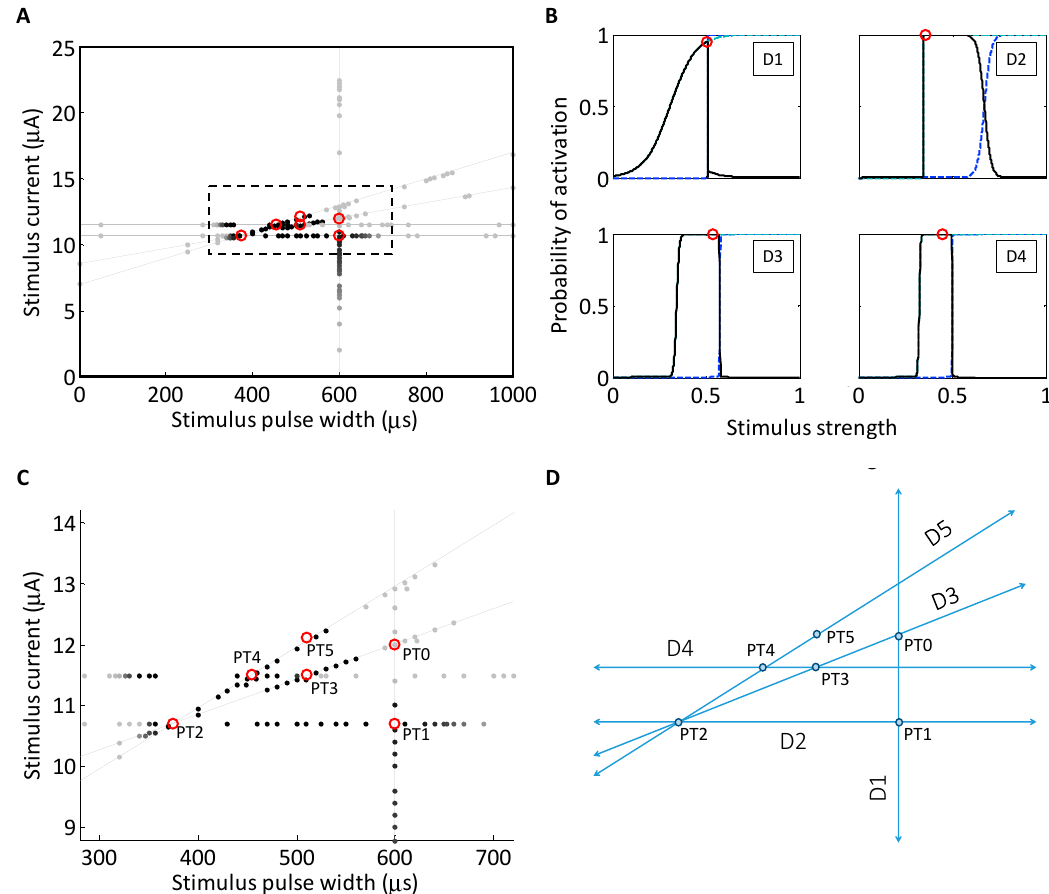
Figure 6. ( A ) Implementation of Powell’s method to search the strength–duration waveform space. The thin lines denote the five search segments. The stimuli applied along each stimulus path is color coded such that the darker the point, the greater the selectivity between the two neurons. The maxima found along the search lines are highlighted with open circles; ( B ) the objective function (solid line) was evaluated along each line search in the search routine of ( A ) according to Equation (3). The objective function for each of the first four searches is plotted in each panel, and the maximum of the objective function is denoted with an open circle, similarly to ( A ). The sigmoidal activation functions for each of the two neurons, N1 and N2, are plotted with dotted lines. The outputs from the first four are depicted here. In all five searches, activation curves for neurons N1 and N2, dotted lines, were estimated from data; ( C ) The implementation of the search routine, magnified from the dashed box in panel ( A ). The starting point, PT0, was chosen near the middle of the range of stimulus currents and pulse widths (600 μ s, 12.0 μ A); ( D ) a cartoon depiction of the search routine, shown in panel ( C ). Each of the search directions and measured peak selectivity points is highlighted.